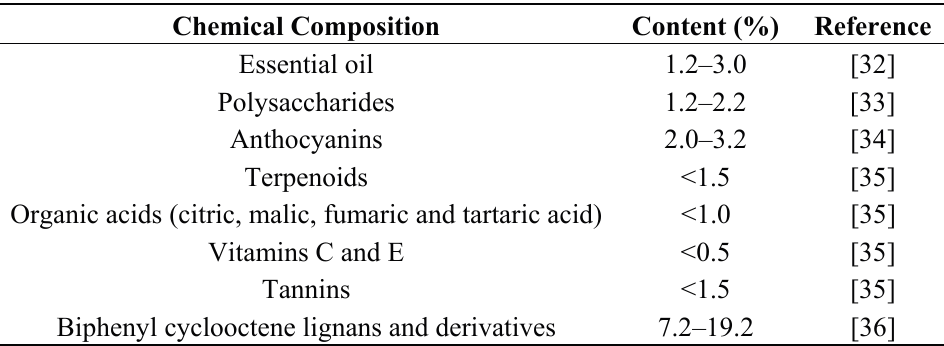
Table 1. Chemical composition of S. chinensis fruits.